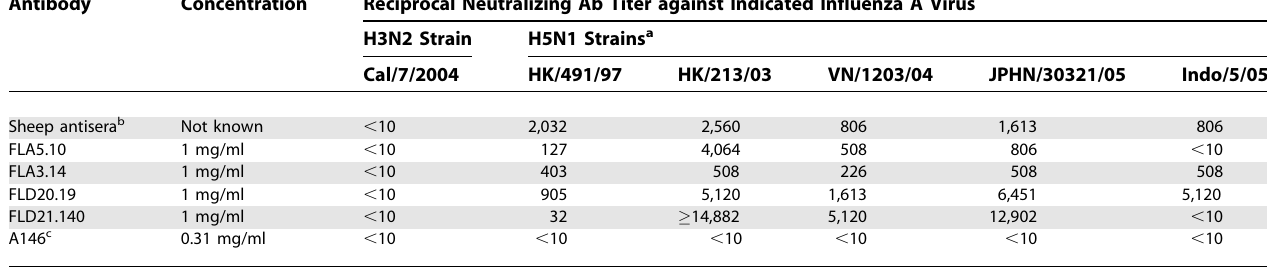
Table 2. Neutralizing Titers of mAbs against Influenza A H3N2 and a Range of H5N1 Influenza Reference Viruses Antibody Concentration